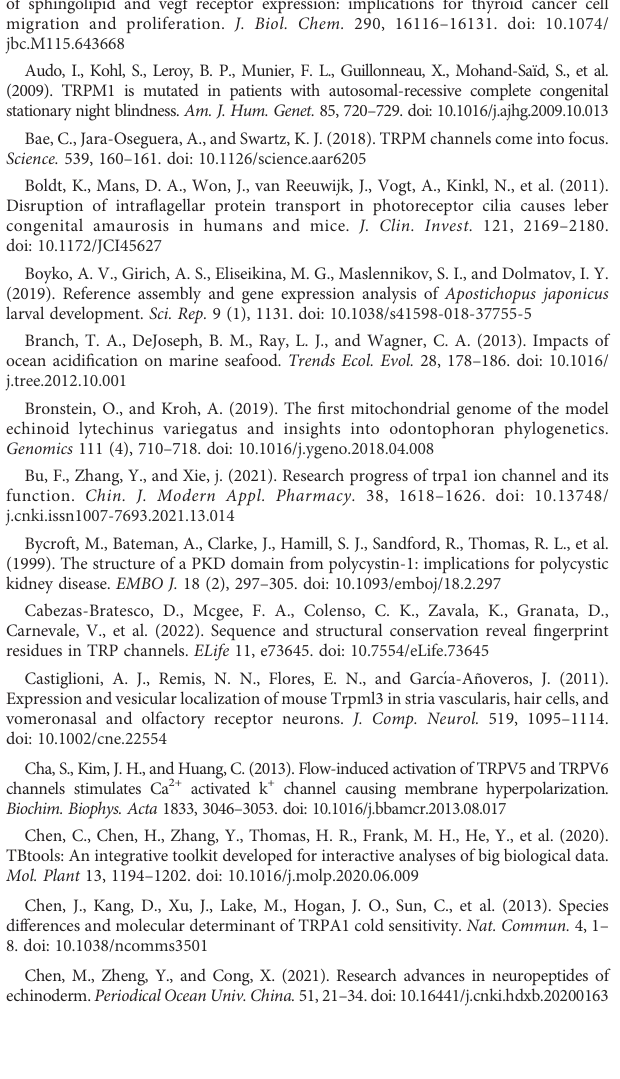
SUPPLEMENTARY FIGURE 3 Distribution of conserved motifs in A. japonicus TRPs. SUPPLEMENTARY FIGURE 4 Multi-sequence comparison of the TRPs domain and fi ngerprint residues of AjTRPs. (A) Multi-sequence comparison of the TRPs domain. (B) Multi- sequence comparison of the fi ngerprint residues. F denotes six carbon aromatic residues (i.e., Tyr or Phe). X denotes any amino acid residue. rTRPV1, transient receptor potential cation channel, subfamily V, member 1 [ Rattus norvegicus (Norway rat)]. The conserved residues in box 1, box 2, and fi ngerprint residues are shown in black and gray shadows.